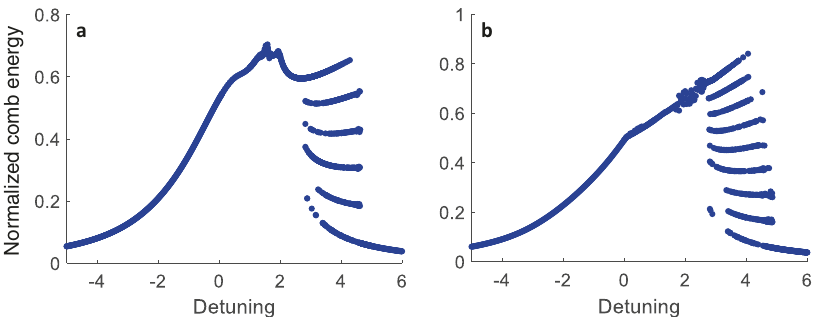
Fig. 2 DTC regions of existence. Comb energy versus detuning curves for a 5-FSR and b 8-FSR separation between the two pumps, when laser powers are kept fi xed. Each data point corresponds to one numerical integration of the governing equations from a random initial waveform till a steady state (for non- chaotic states) prevailed. Spontaneous soliton formation occurs in step-like regions to the right of the curves. Dispersion parameter matching the experimental resonator ( D 2 = 2 π × 6.8 kHz) was used. The horizontal axis shows the normalized detuning of the stronger pump ( − σ 1 / κ ), for fi xed detuning difference between the lasers ( σ 2 = σ 1 + D 2 M 2 /4); see Methods. In a normalized pump powers were (1.4, 0.9), and in b they were (1.5,